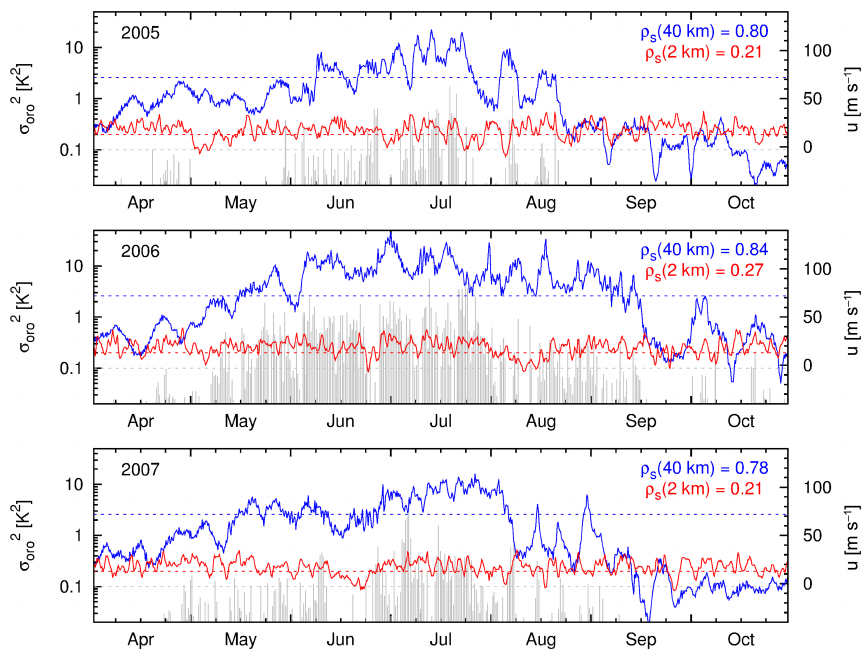
Figure 5. Time series of AIRS 4.3µm brightness temperature variance differences (gray) and ERA-Interim zonal winds at 2km (red) and 40km (blue) log-pressure altitude from 1 April to 31 October in 2005 (top), 2006 (middle), and 2007 (bottom) at the Kerguelen Islands. Dotted lines indicate the 0.1K 2 threshold used to detect orographic gravity waves and zonal wind levels of 13 and 72ms − 1 used to predict mountain wave events in the AIRS